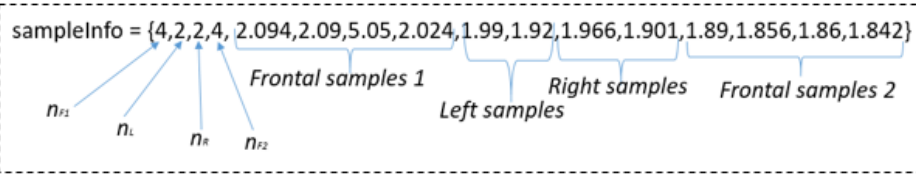
Figure 5. Sample data array structure.